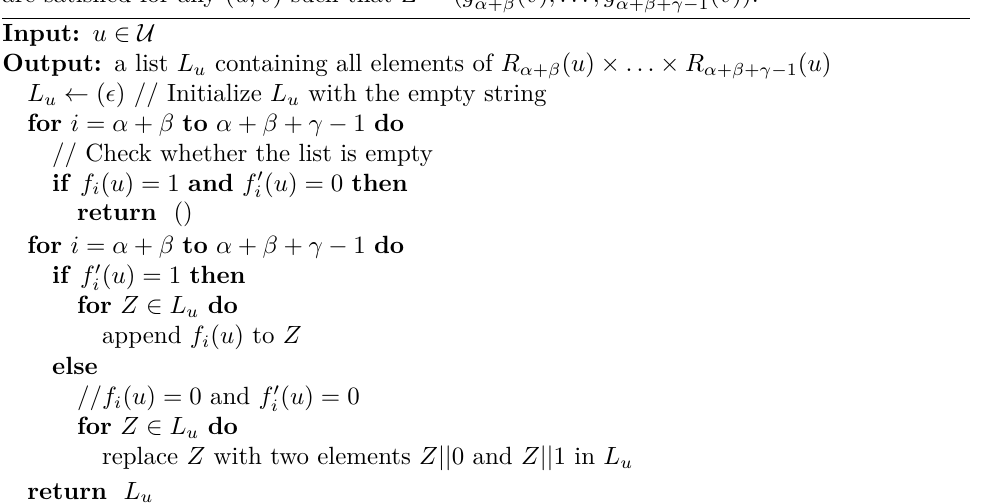
( v ) , . . . , g 0 ( v )). α + β α + β + γ − 1